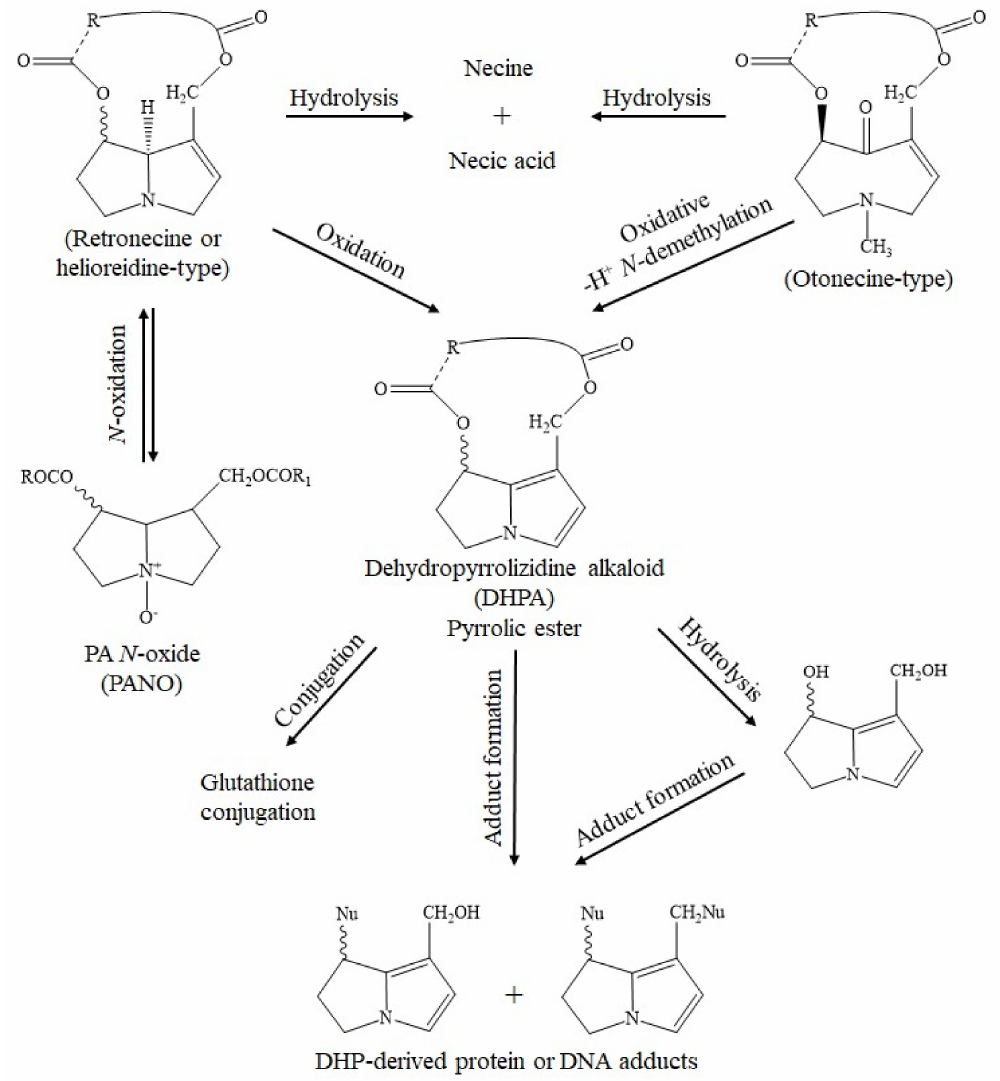
Figure 9. The fate of 1,2-unsaturated PAs to adduct formation. Different steps are delineated leading from 1,2-unsaturated PAs to their adduct formation with proteins and DNA. DHPA is partially detoxified through conjugation with glutathione. Abbreviations: DHP, dehydronecine pyrrolizidine; DHPA, dehydropyrrolizidine alkaloid; PA, pyrrolizidine alkaloid. The figure was retrieved from the open access report of Schramm et al.